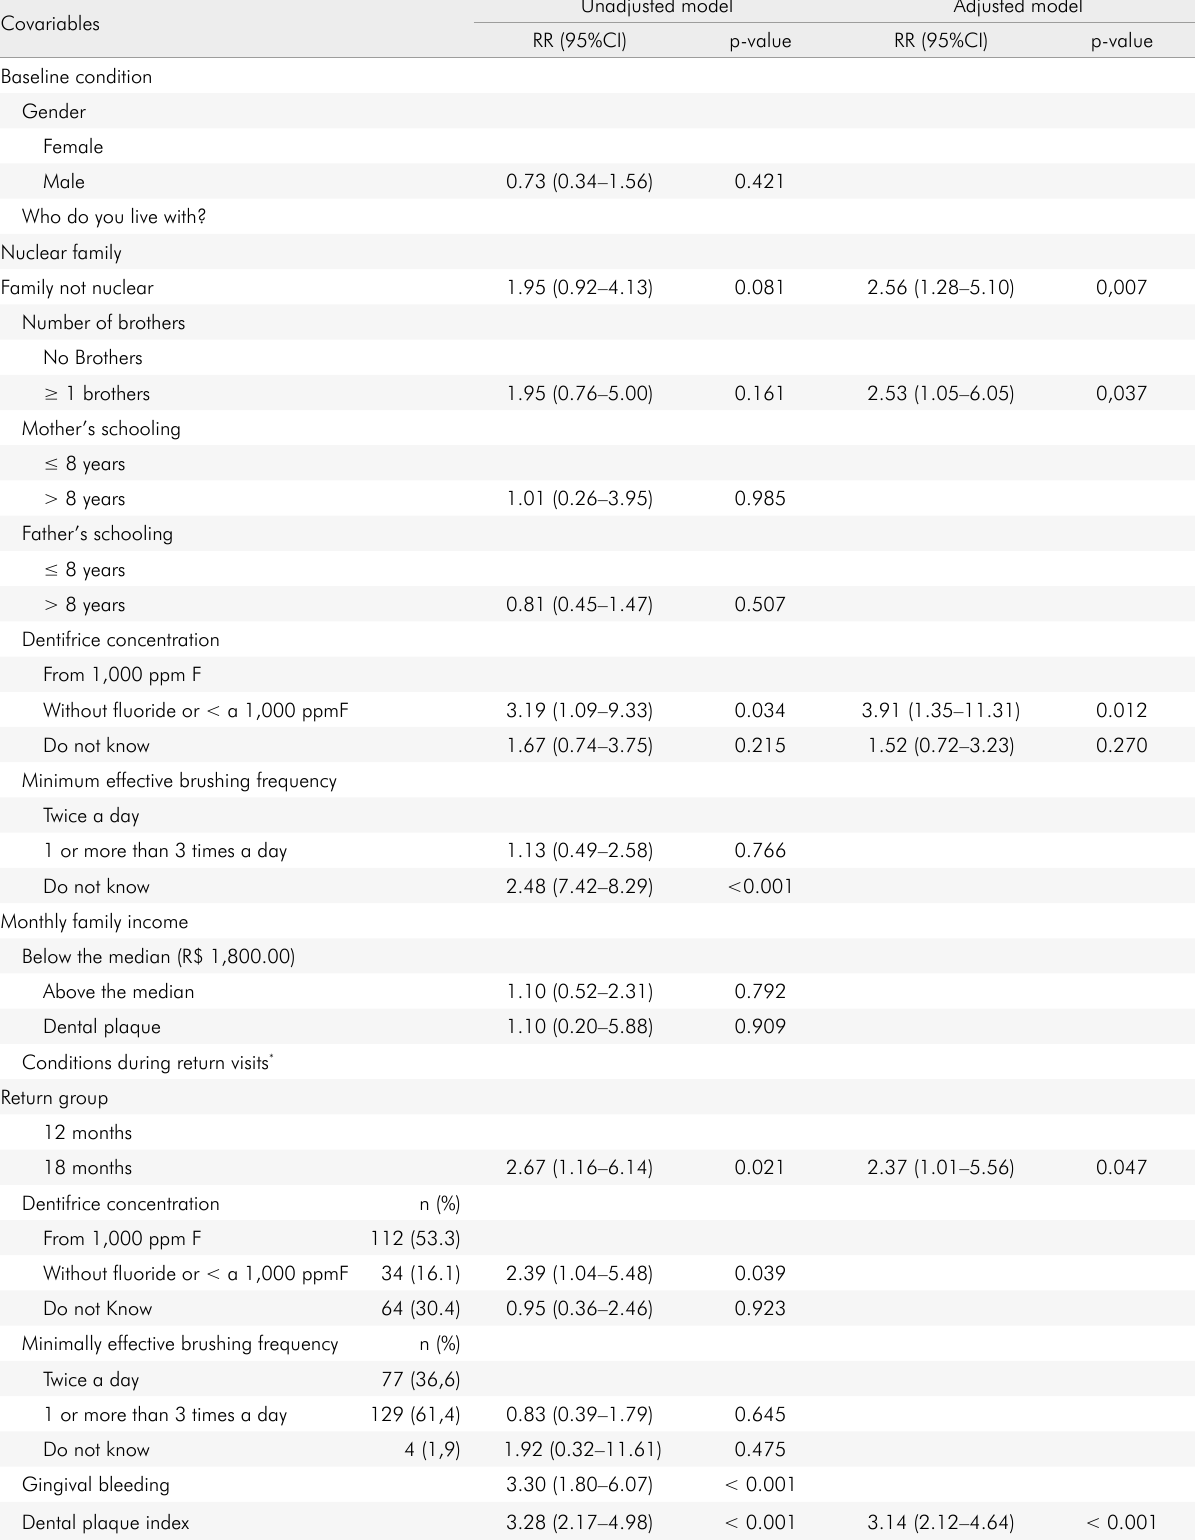
Table 4. Adjusted and unadjusted Poisson Regression analysis of the variables associated with the incidence of new active non-cavitated caries lesions (active d1ICDAS) (n =